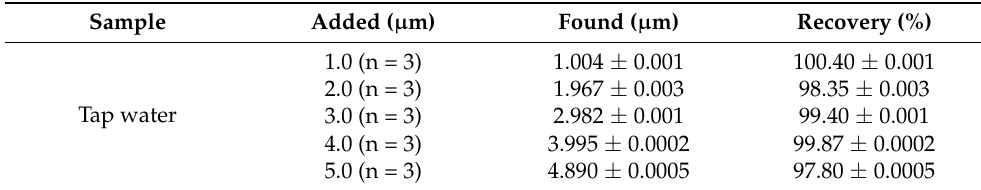
Table 3. The recovery data of ICN in tap water